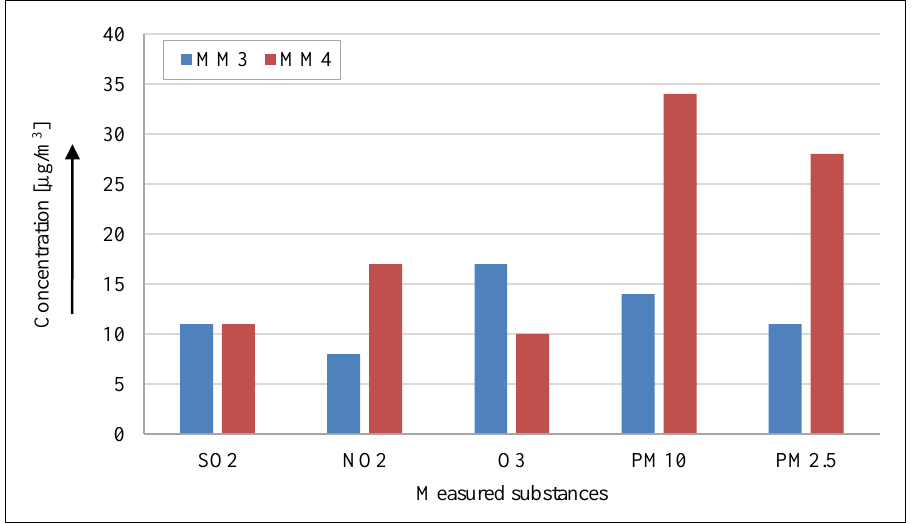
Figure 8. The concentration of SO 2, NO 2, O 3 , PM 10 and PM 2.5 measured hourly